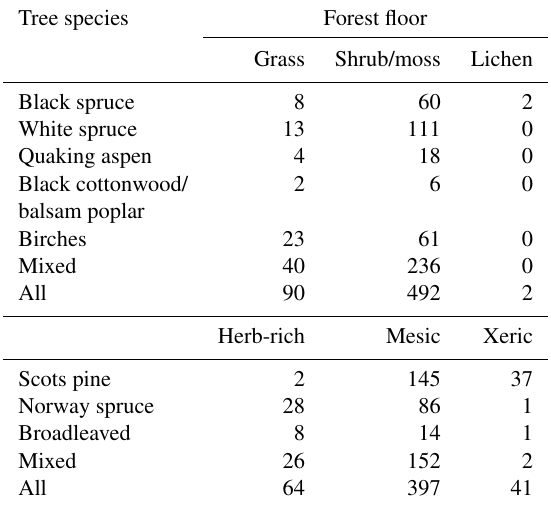
Table 2. Number of study plots by dominant tree species and forest floor type. The species dominance was determined by basal area proportion: if the basal area of one of the species exceeded 80% of the total basal area, the plot was considered to be dominated by that